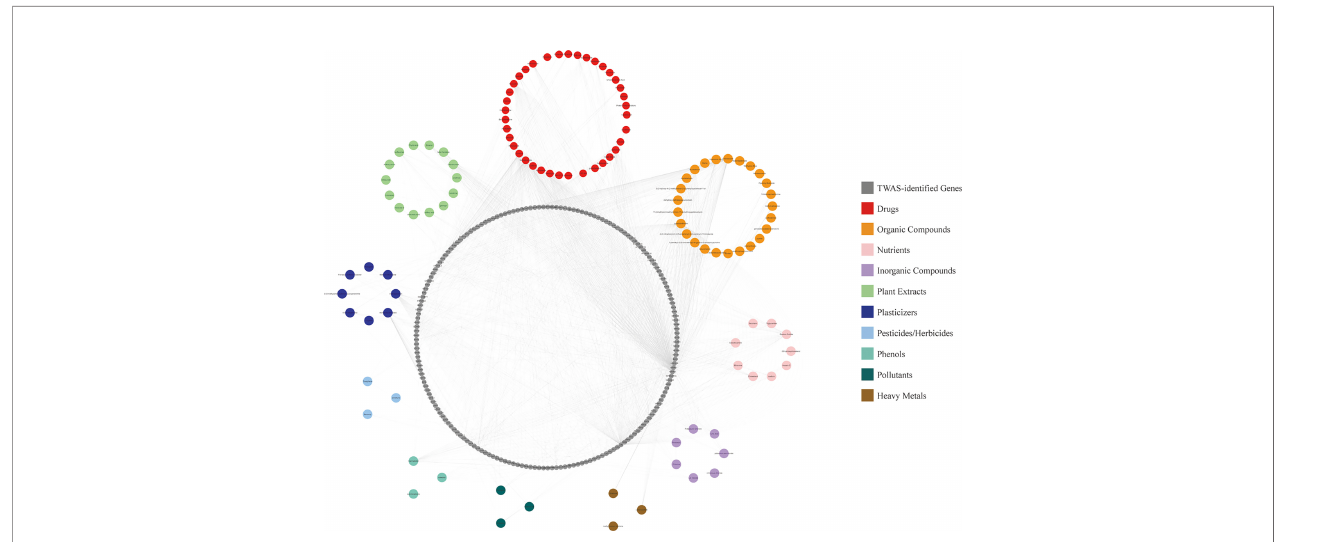
FIGURE 4 | CGSEA results. Network of EEDs and their target genes, based on the TWAS-identi fi ed genes.